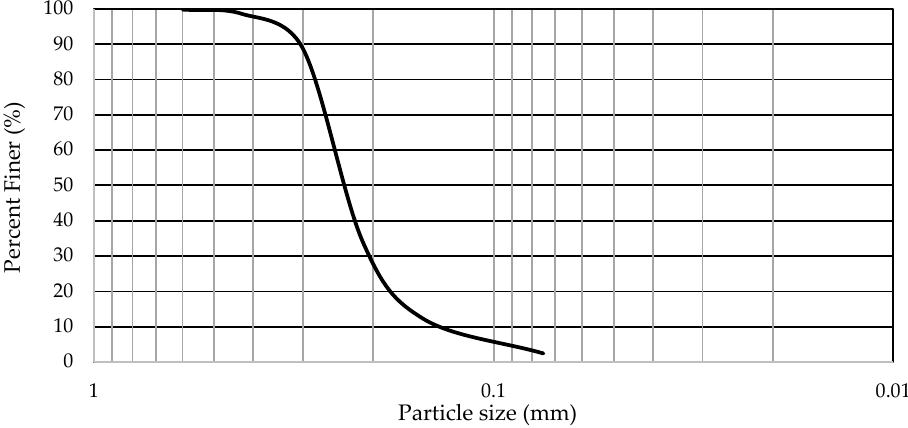
Figure 2. Particle-size distribution curve.